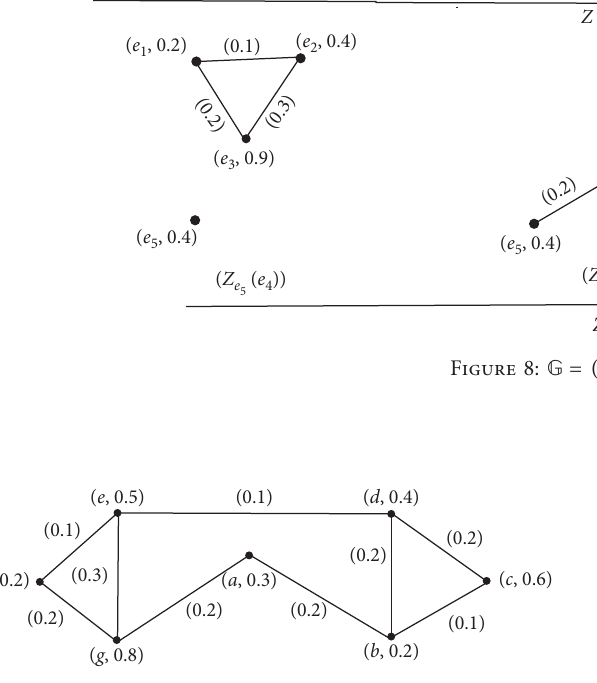
Figure 10: G � ( Z ( c ) , Z ( f ))